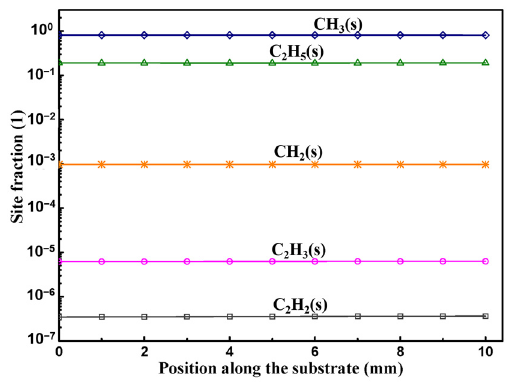
Figure 3. Site fraction of adsorbed C surface species on Si face. From reactions RS22 ~ RS25, Si and SiH could contribute to the growth of epitaxial layer [45] by adsorbed on CH 2 (ads) and CH 3 (ads); however, neither Si nor SiH is the intermediate species of the MTS-H 2 gas phase reaction mechanism employed in this model. Assumed that the mole fraction of Si and SiH above the substrate are ~10 − 5 and ~10 − 6 , respectively, the predicted growth rate by reactions RS1~RS25 is as shown in Figure 4. The predicted growth rate is relatively lower than the reported data [52,53] of 4H SiC,